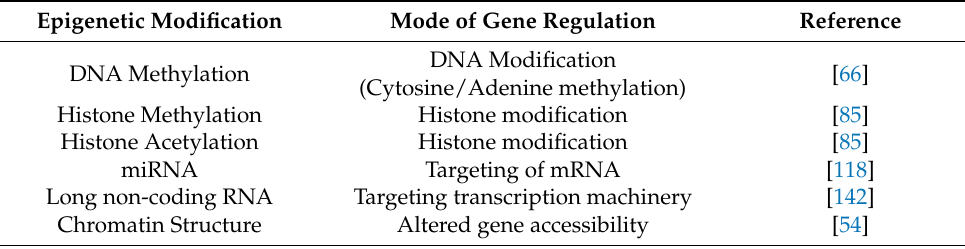
Table 1. The key epigenetic modifications in MSC and their modes of gene